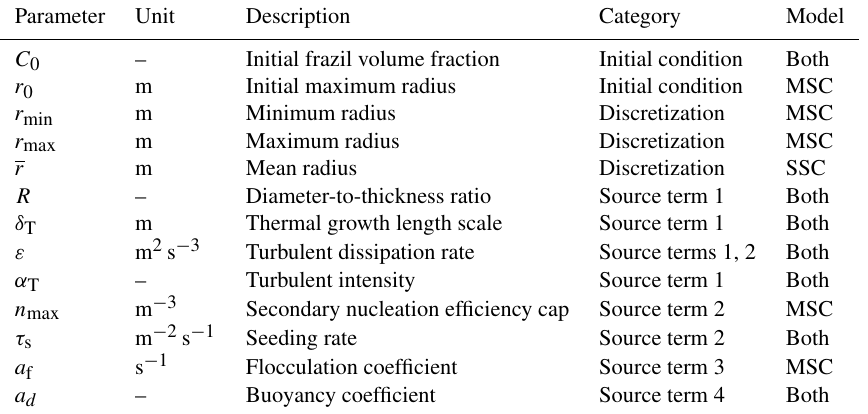
Figure 1. MSC model convergence in the number of classes with C 0 = 4 . 5 × 10 − 8 , r 0 = 0 . 2mm, r min = 10 − 5 m, r max = 10 − 2 m, d t = 0 . 1s, crystals per class (a) at initial time (black) and at time t = 300s (color). Water temperature and frazil volume fraction vs. time (b) . Table 1. Description of uncertain parameters of the frazil ice models. Parameter Unit Description Category